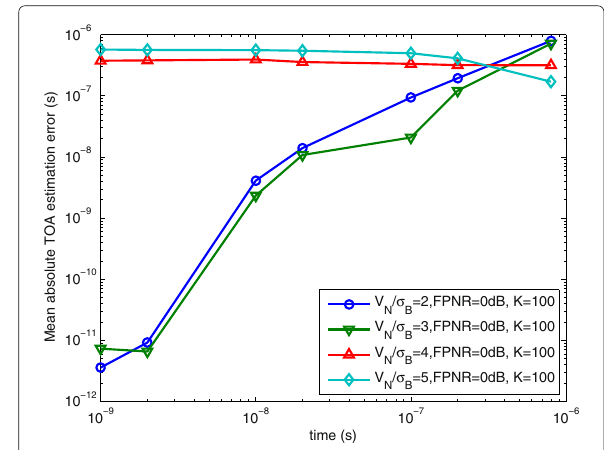
Fig. 9 TOA estimation error for low FPNR with V N /σ B as